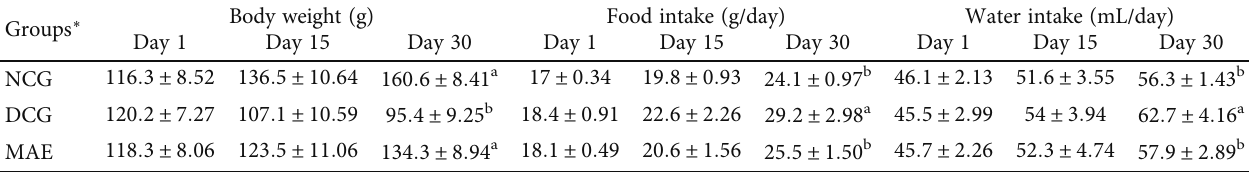
Table 3: E ff ects of treatment with MAE on body weight, food intake, and water intake in STZ-induced diabetic rats. Groups ∗